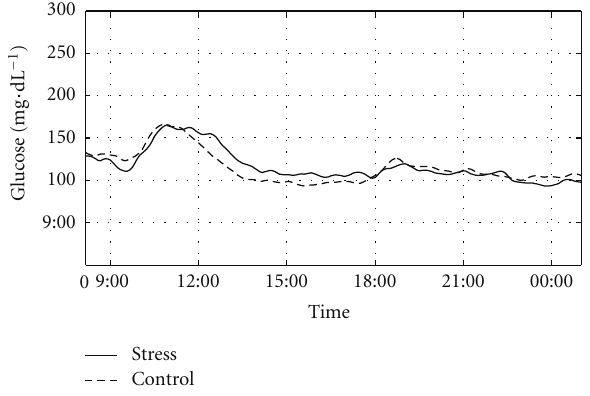
Figure 4: Glucose response curves obtained over 24h via CGMS following the stress (solid line) or control (broken line) conditions. Data are mean values; Time = time of day; N = 17. To convert to the International System of Units (mmol), multiply glucose values by